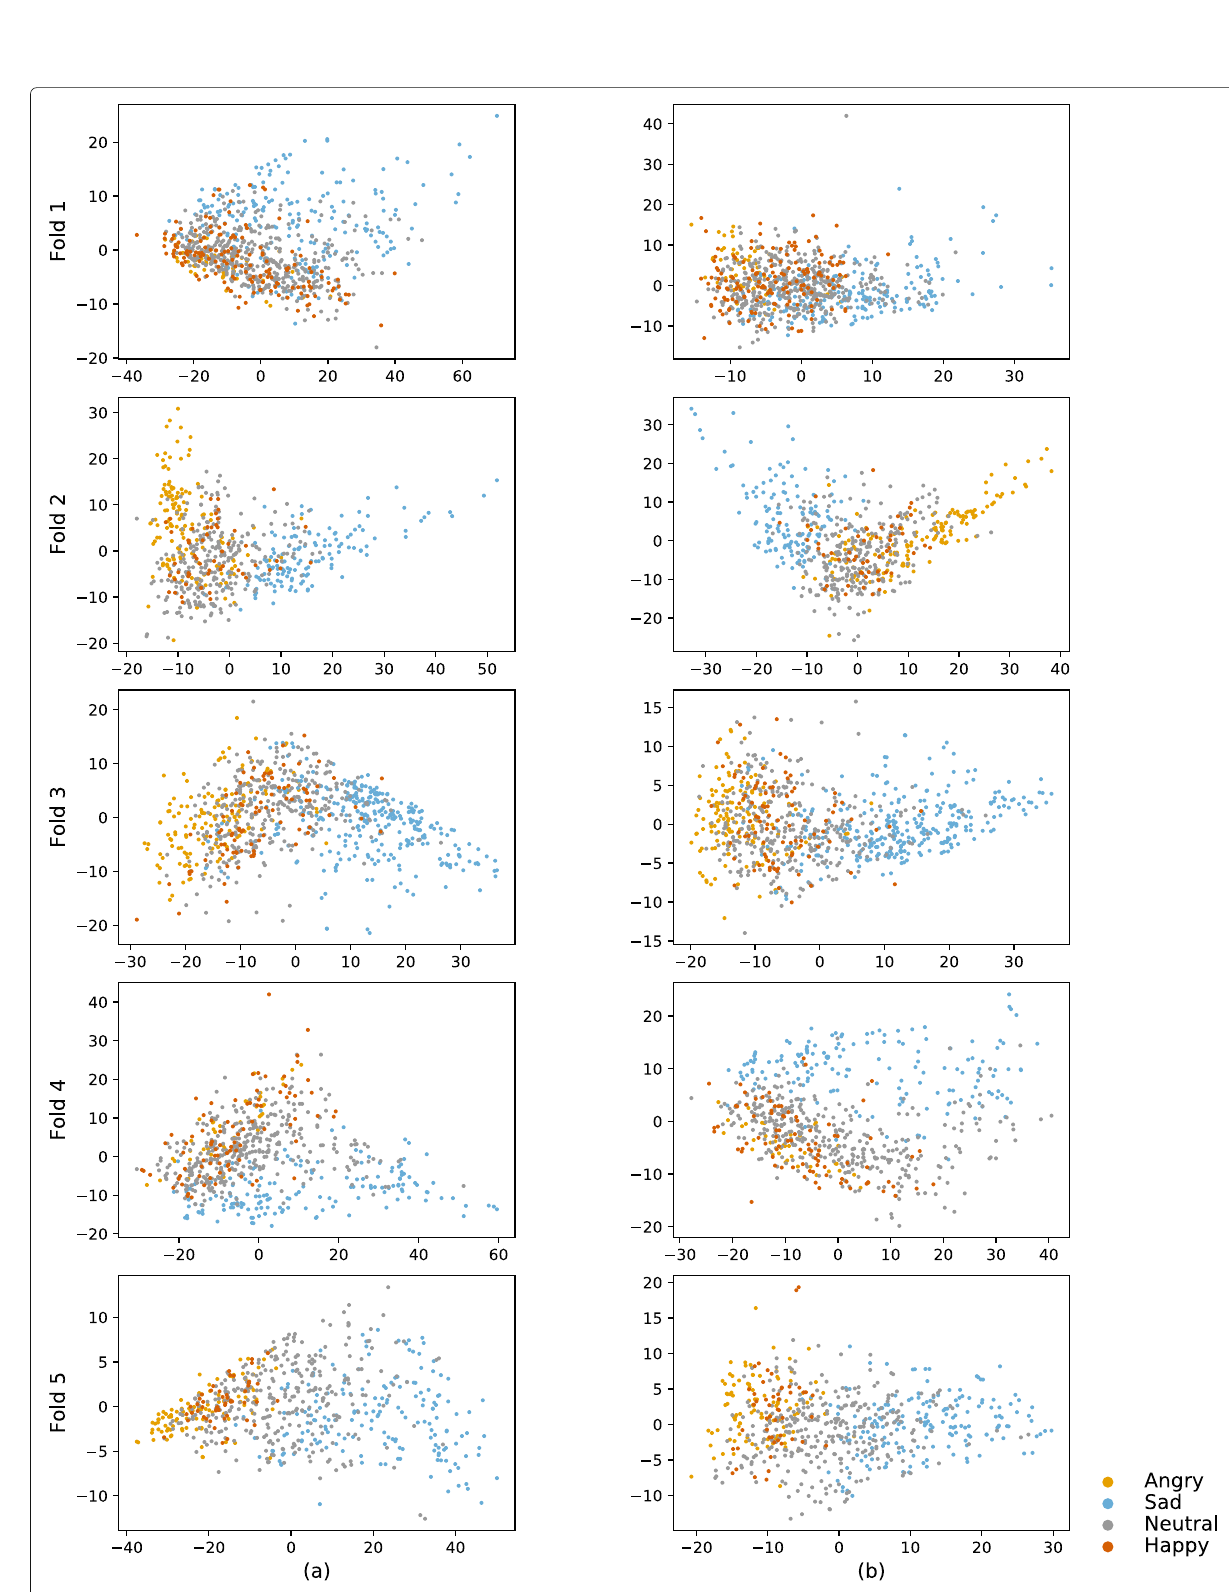
Fig. 8 Visualisations of the local contexts of the testing sets from the IEMOCAP